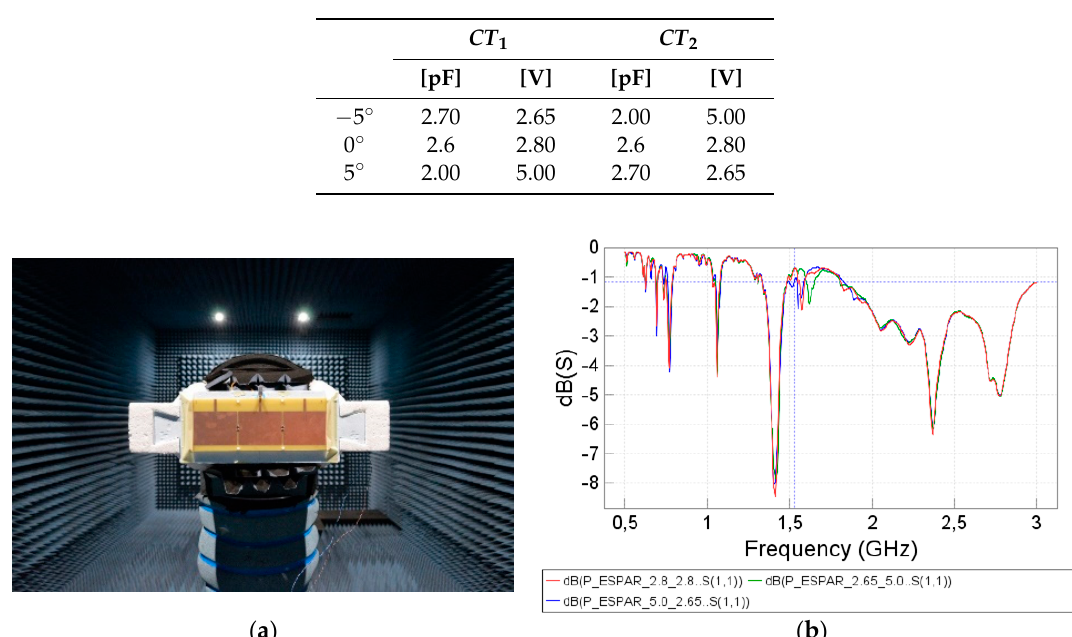
Figure 20. ( a ) Antenna in the anechoic chamber and ( b ) respective results of |S 11 | with a variation of 0 ± 5°.